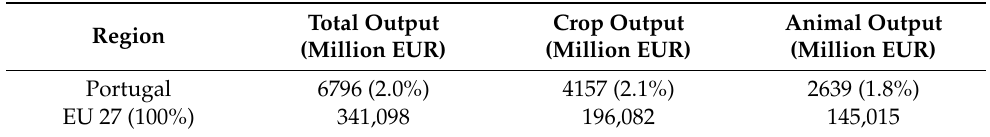
Table 2. Portugal and EU: comparative total agro-industry output, crop output and animal output, in 2019 [7].